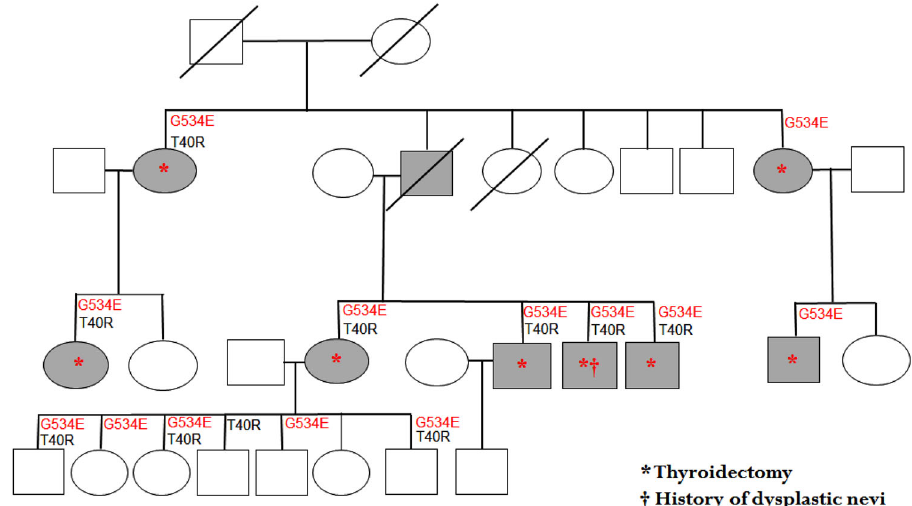
Fig. 1 The family pedigree showing the status of ZNF23_T40R and HABP2_G534E variant with respect to non-medullary thyroid cancer. Squares denote male family members, circles female members, shaded symbols affected members and slashes deceased